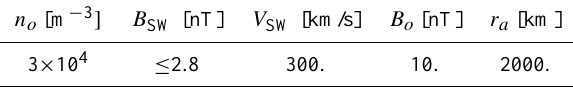
Table 1. Plasma parameters and the object